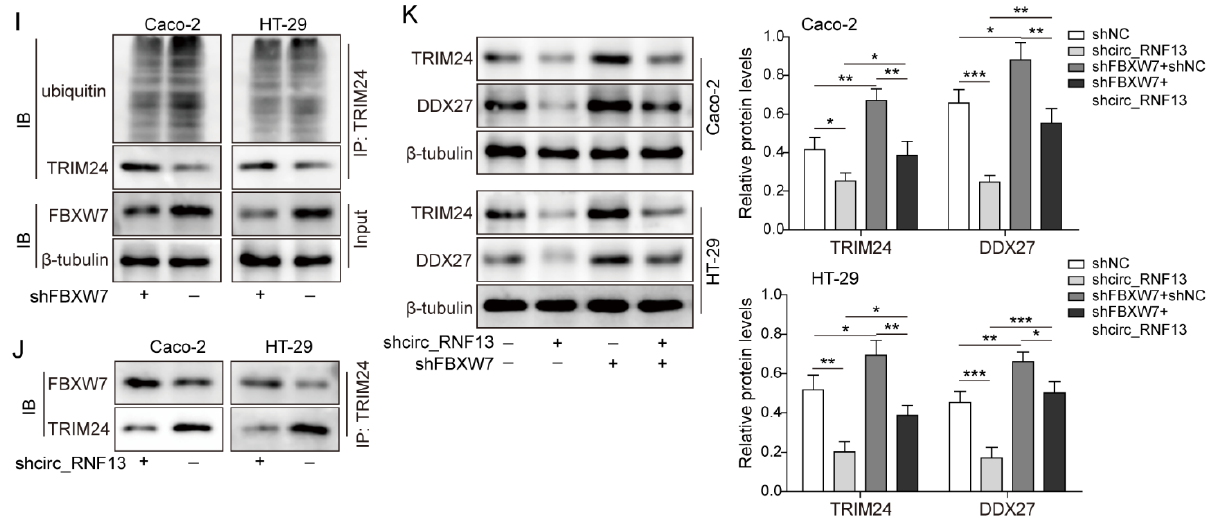
Figure 6. Circ_RNF13 stabilizes TRIM24 via suppressing FBXW7-mediated TRIM24 degradation. ( A ) The mRNA level of TRIM24 was detected by qRT-PCR. ( B ) The protein level of TRIM24 was detected by Western blot analysis. ( C ) The transfected HT-29 and Caco-2 cells were treated with CHX. The protein level of TRIM24 was detected by Western blot analysis. ( D ) HT-29 and Caco-2 cells were treated with MG132. The protein level of TRIM24 was detected by Western blot analysis. ( E ) The shcirc_RNF13-transfected HT-29 and Caco-2 cells were treated with MG132. The protein level of TRIM24 was detected by Western blot analysis. ( F ) The direct interaction between FBXW7 and TRIM24 was detected by Co-IP. ( G ) HT-29 and Caco-2 cells were transfected with sh-FBXW7. The protein levels of TRIM24 and FBXW7 were detected by Western blot analysis. ( H ) The transfected HT-29 and Caco-2 cells were treated with CHX. The protein levels of TRIM24 and FBXW7 were detected by Western blot analysis. ( I ) The ubiquitination of TRIM24 was detected by Co-IP. ( J ) HT-29 and Caco-2 cells were transfected with sh-circ_RNF13. The interaction between FBXW7 and TRIM24 was detected by Co-IP. ( K ) HT-29 and Caco-2 cells were transfected with sh-circ_RNF13 or/and sh-FBXW7. The protein levels of DDX27 and TRIM24 were detected by Western blot analysis. Each experiment was performed at least three times independently. *, p < 0.05, **, p < 0.01, ***, p < 0.001. Full pictures of the Western blots are presented in Figure S2.